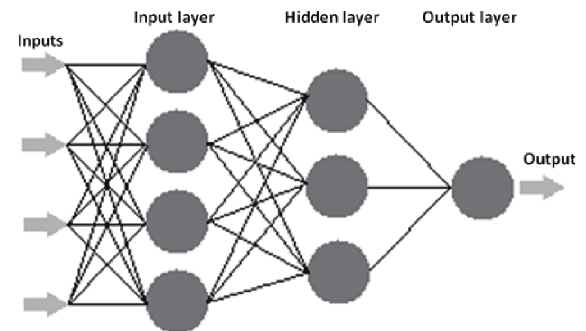
Fig. 2. ANN: Basic Multilayer Perceptron